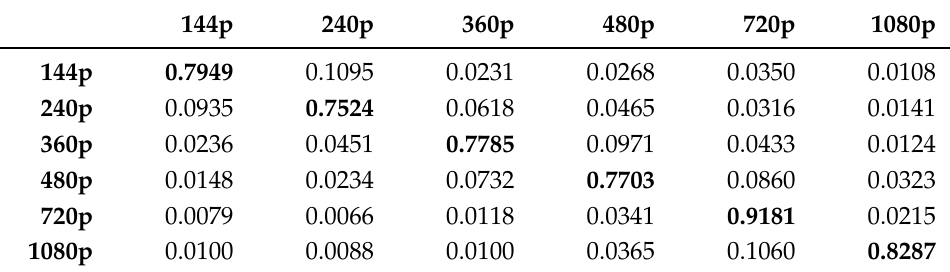
Table 12. Quality prediction result—full feature set.